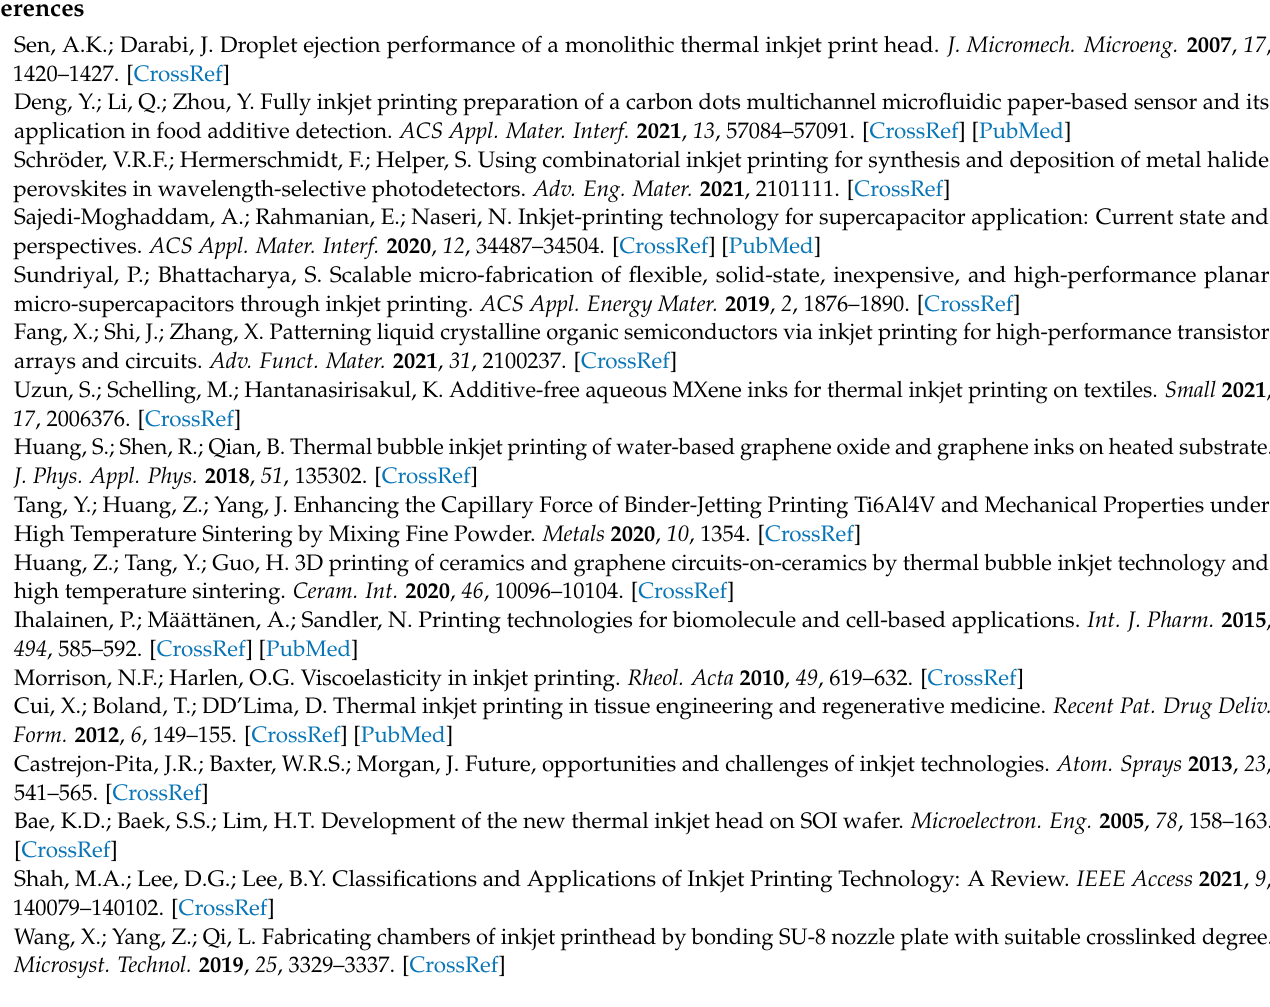
interface; Figure S2: Schematic of the rectangular waveform used with RF-T16 droplet generator; Figure S3: The optical image of nozzle hole with the diameter of 40 µ m; Figure S4: (a) Time series droplets recorded with a drop-in-flight analysis system for pigment ink (inset image is the black pigment ink); (b) the optical image of printed droplet patterns at different jetting